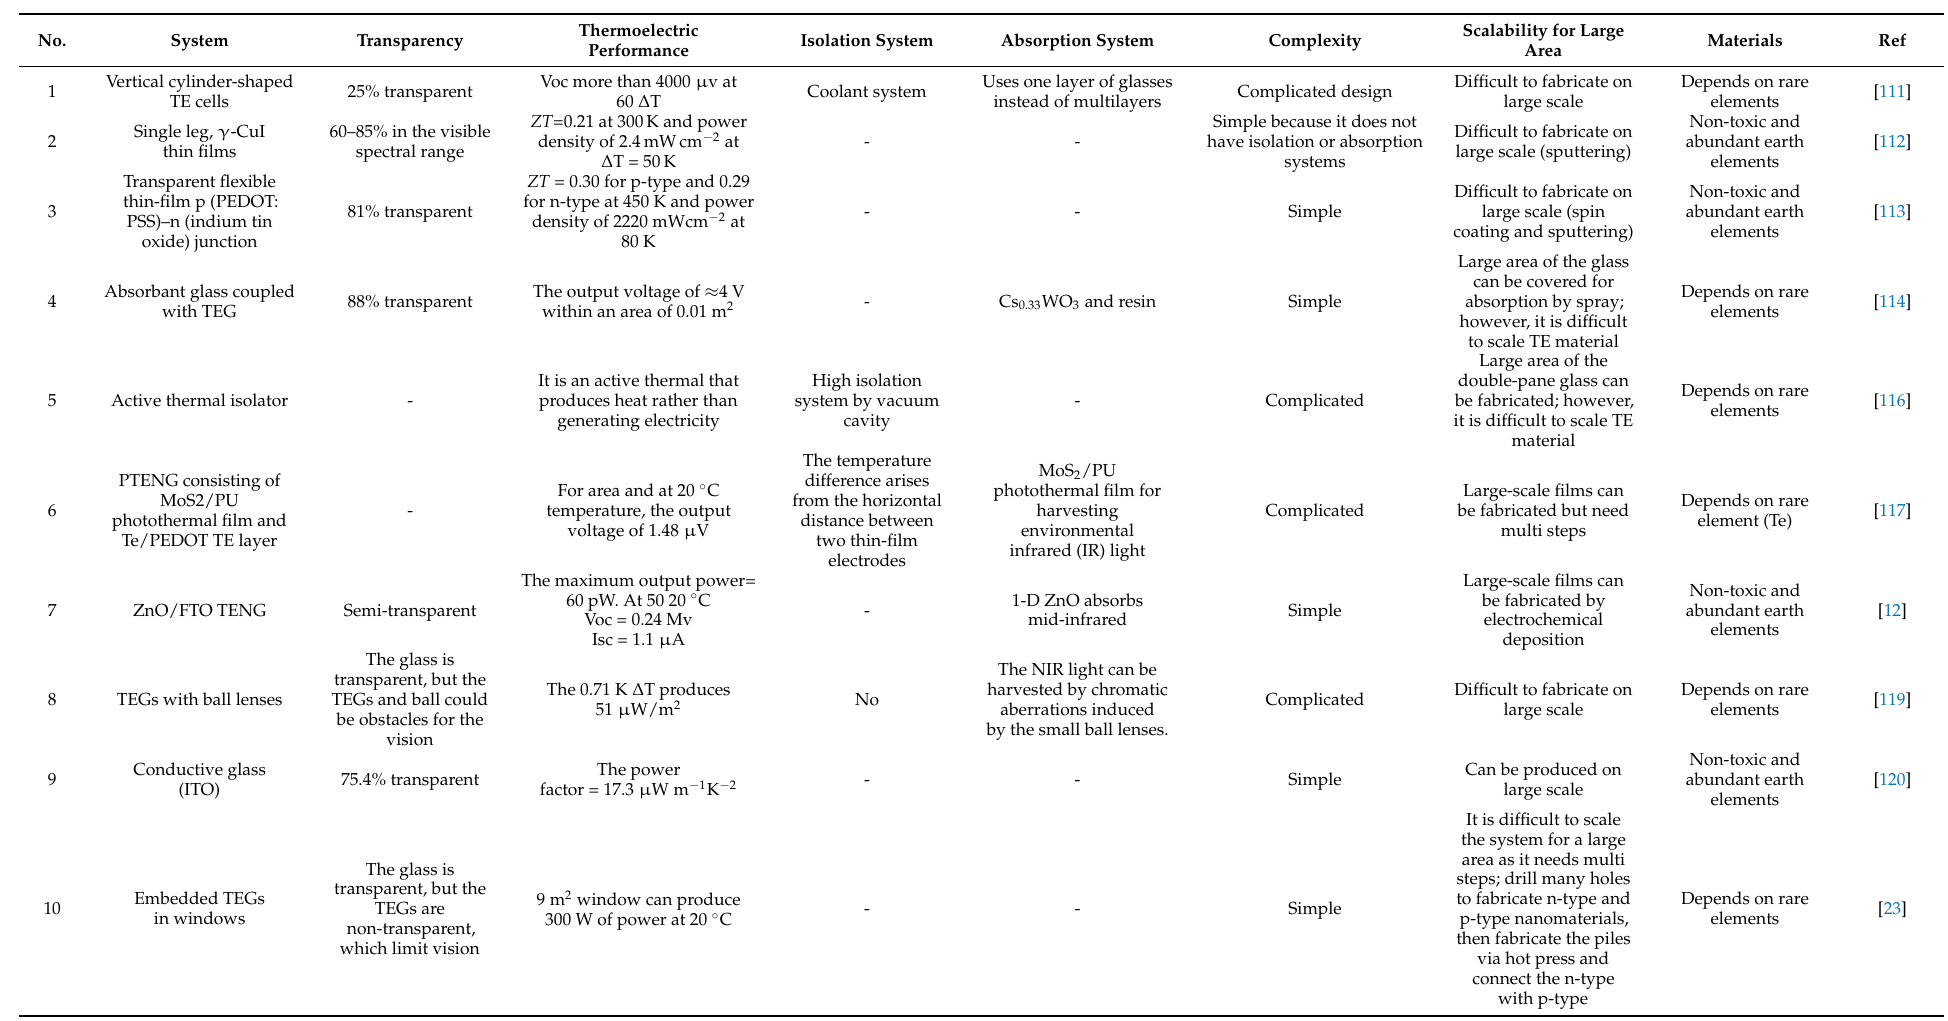
Table 1. Summary of latest TGZ